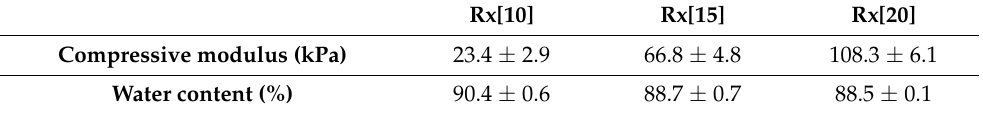
Table 1. Typical properties of prepared radiation-crosslinked hydrogels